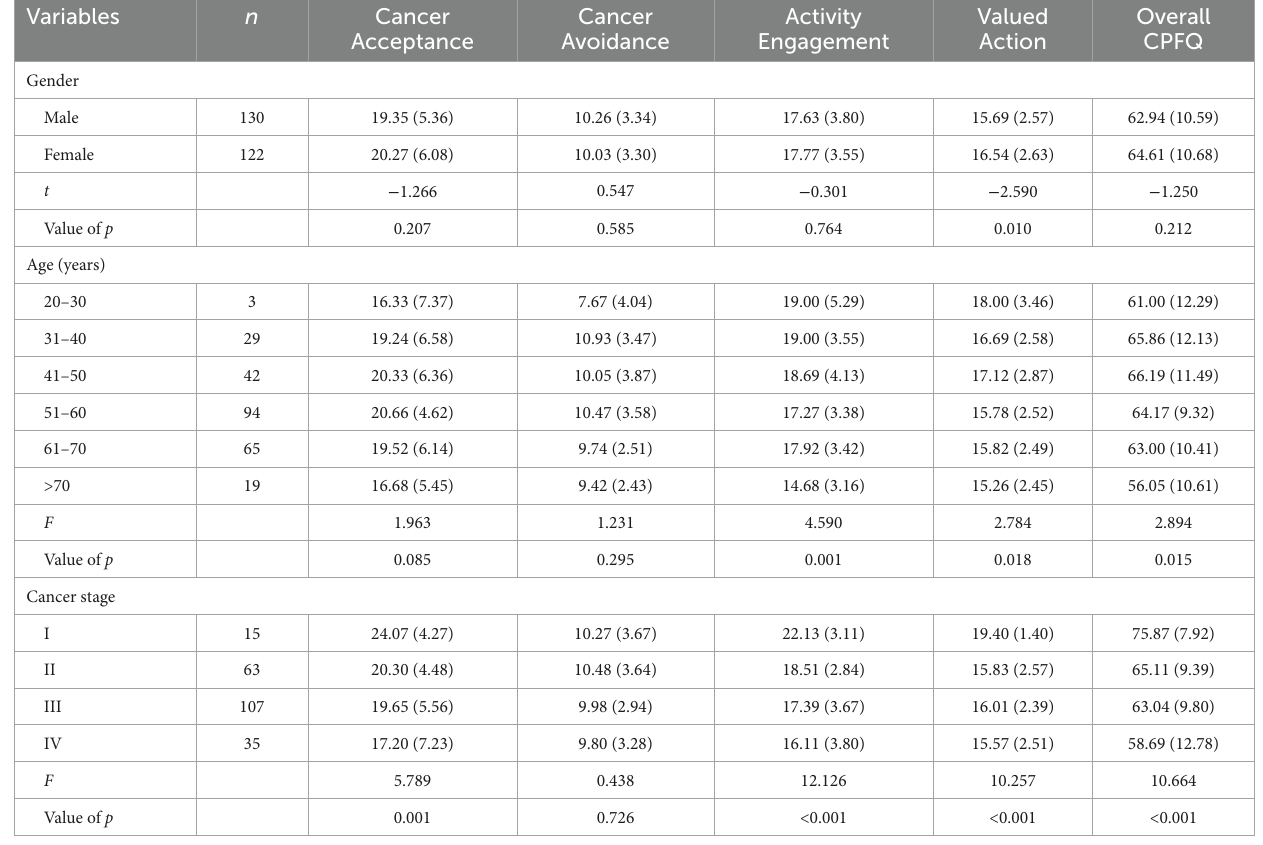
TABLE 3 Effects of gender, age, and cancer stage on the overall and four dimensions of CPFQ.